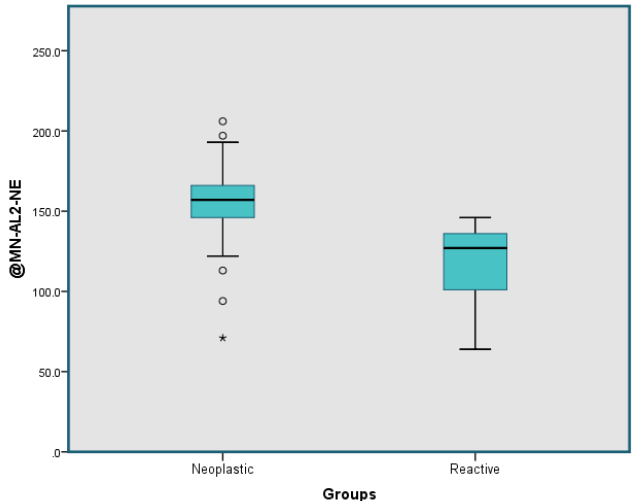
Figure 5. Box and whisker plot for the MN-AL2-NE parameter depicting a comparison of the two groups in this study (neoplastic vs. reactive). There was an outlier marked as “*” in the neoplastic group.